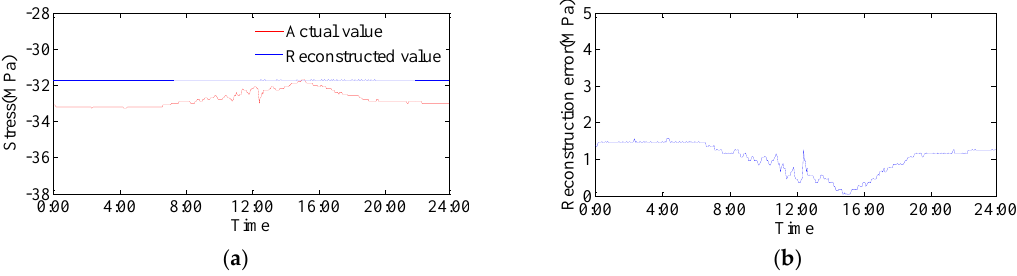
The contrast curves between reconstructed values and actual values are shown in Figure 6. The average absolute error is 1.03 MPa and the relative error is 3.13%.